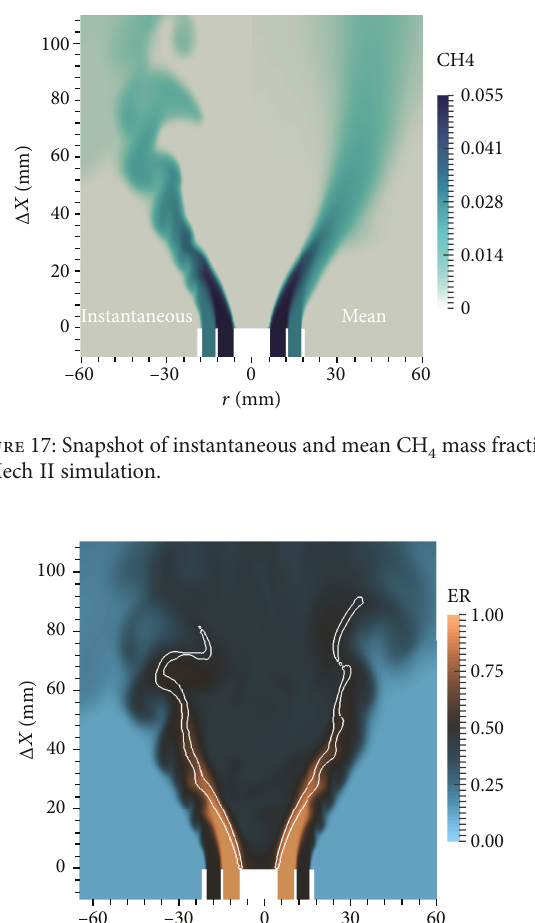
Figure 18: Snapshot of instantaneous ER distribution of Mech II simulation (solid line, fl ame